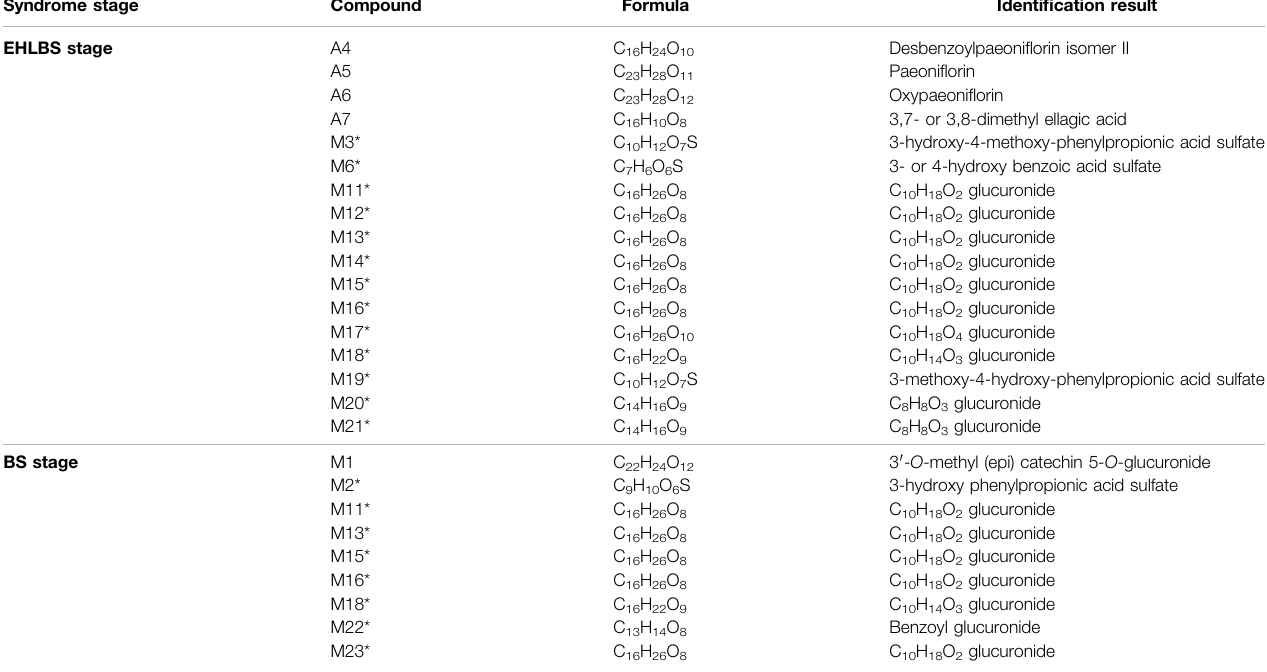
TABLE 6 | The information of 26 potential effective substances of PRR screened out in EHLBS stage and BS stage. Syndrome